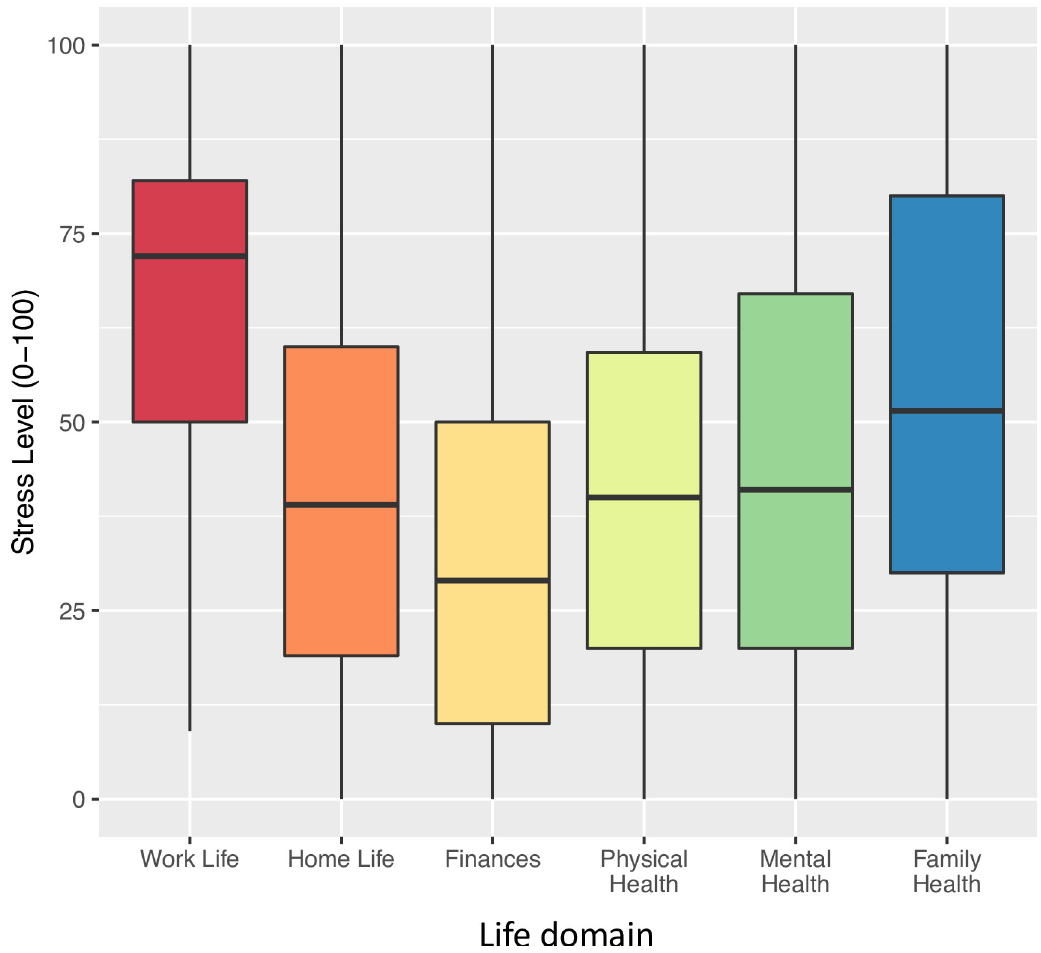
Fig 2. Stress levels attributed to specific life domains. Participants were asked to rate their level of stress relative to each “life domain” on a scale from 0–100.